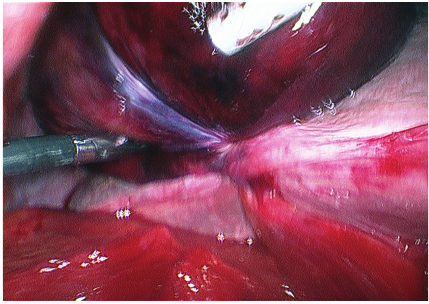
Figure 3: 3-Dimensional volume reconstruction CT abdomen to confirm a distended gallbladder with a clear transition point (arrow),pericholecysticfluid,inflammatorystrandingandenhance- ment of the gallbladder